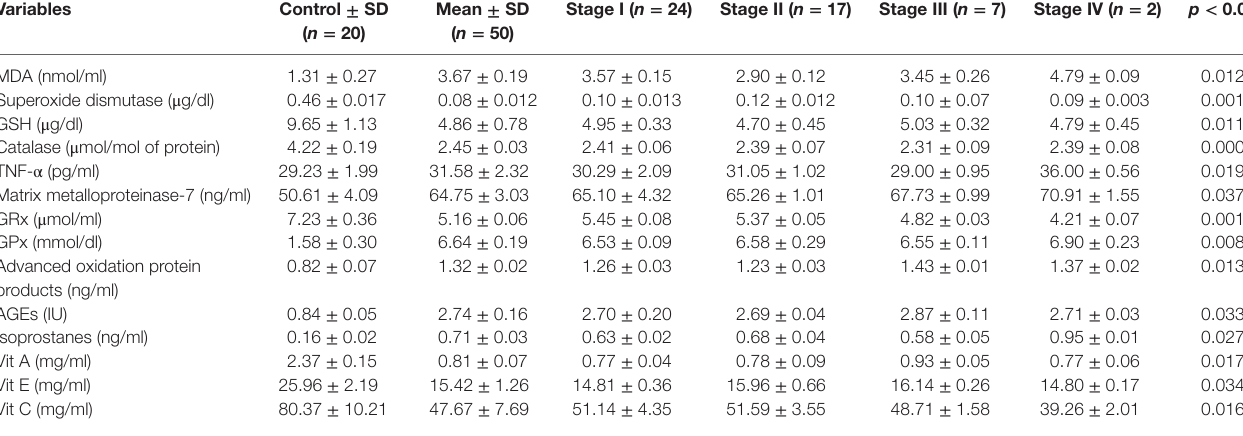
TaBle 1 | Profile of different variables having potential role in the development of colorectal cancer at different stages.